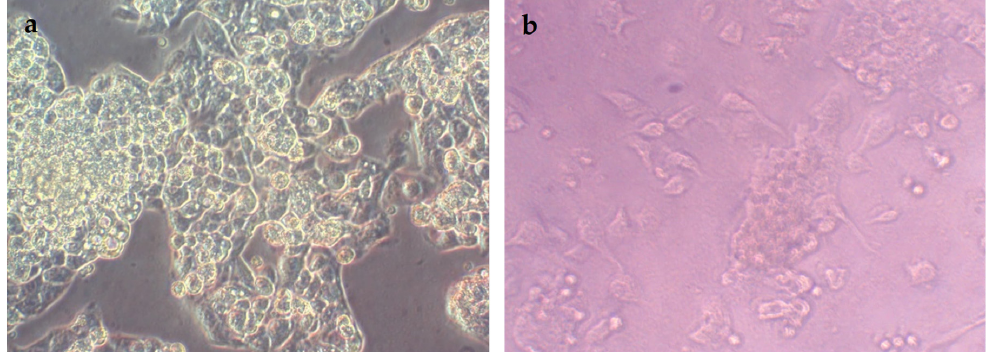
Figure 8. Characteristic pictures of non-treated ( a ) and treated ( b ) NPs activity against HepG2 cell line. Table 2. Viability of human hepatocellular carcinoma (HepG2) cells treated with the di ff erent NPs.